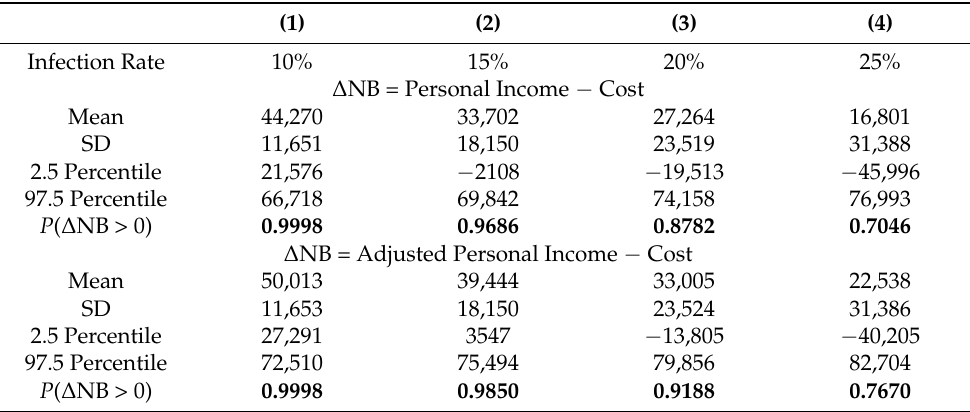
Table 5. Summary statistics (in dollars) of the ∆ NB distributions for